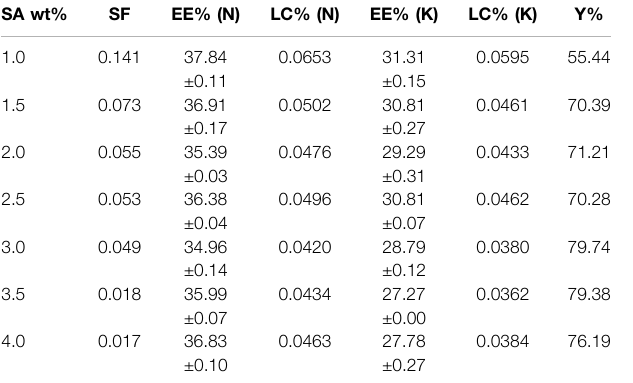
Frontiers in Bioengineering and Biotechnology |